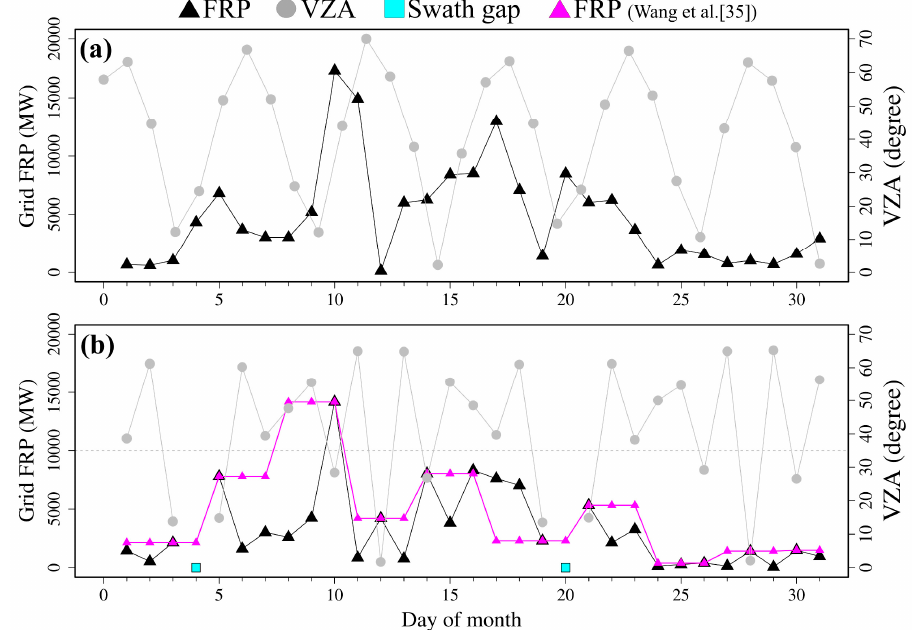
Figure 11. Mean VZA and daily grid FRP from ( a ) VIIRS and ( b ) MODIS in a 1° grid centering at 30.232°E and 4.139°N in January 2017. The black triangle represents grid FRP and the gray solid cycle is VZA. In ( b ), the cyan squares indicate the days without valid MODIS fire observations due to swath gaps and the dashed line of 35° VZA is considered as a VZA threshold to adjust MODIS FRP (results are denoted as pink triangles) based on the algorithm proposed by Wang et al. [35].